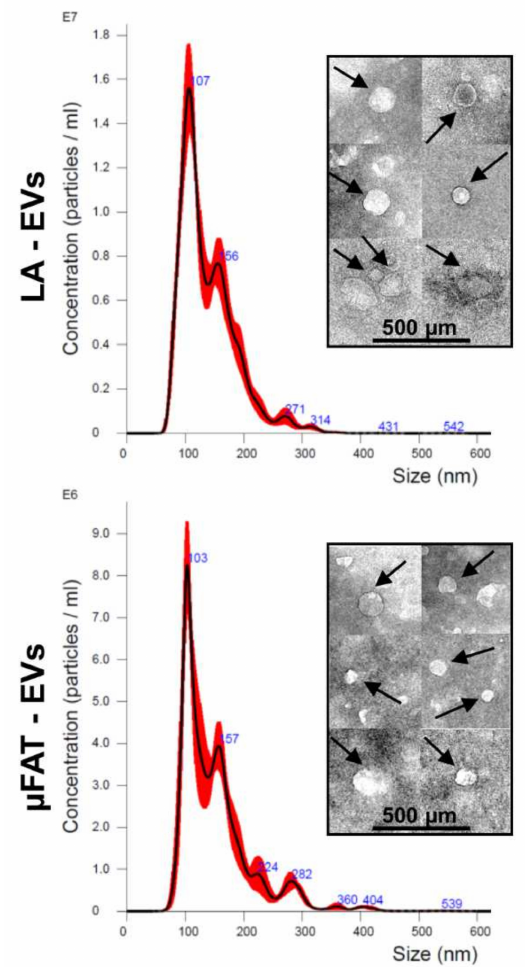
Figure 6. Phenotype of EVs released from µ FAT and LA. NTA generated plots showing size dis- tribution and of isolated particles. Images from a representative donor are shown. In the boxes, transmission electron micrographs of isolated EVs, as indicated by